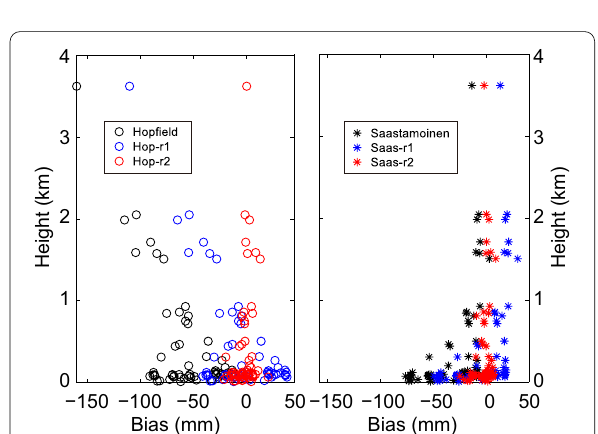
Fig. 5 Change in the bias with the height of a site for the six models